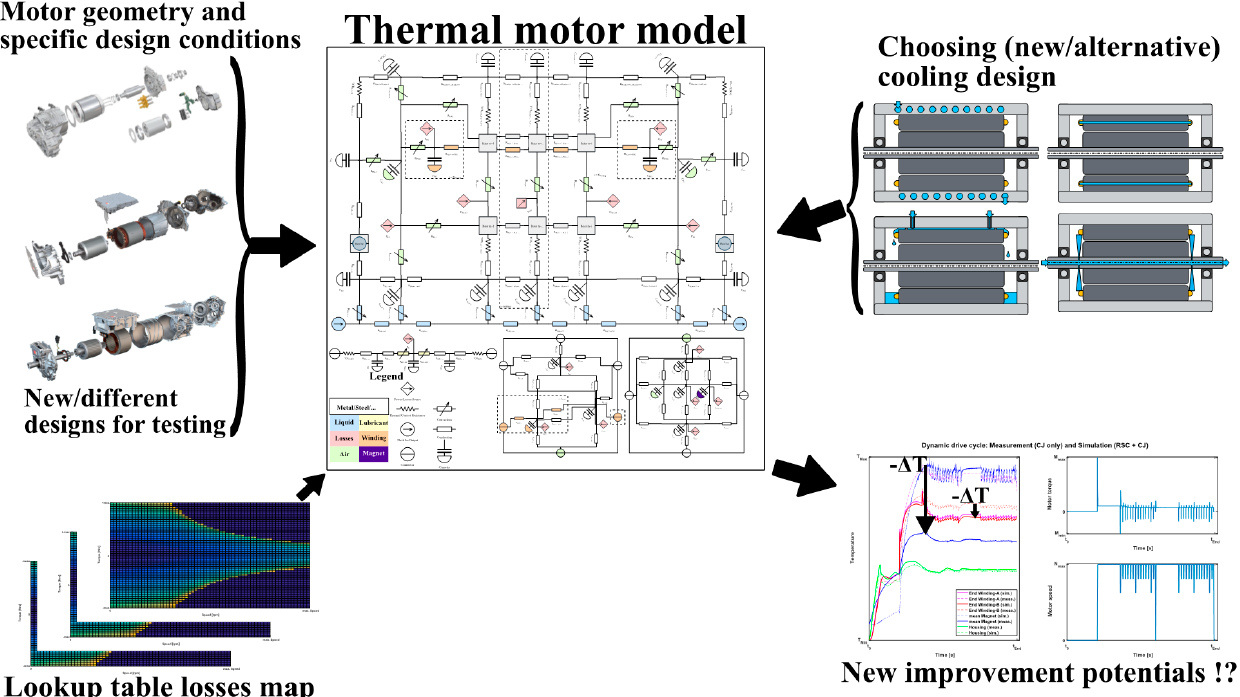
Figure 2. Optimization process with the thermal model.